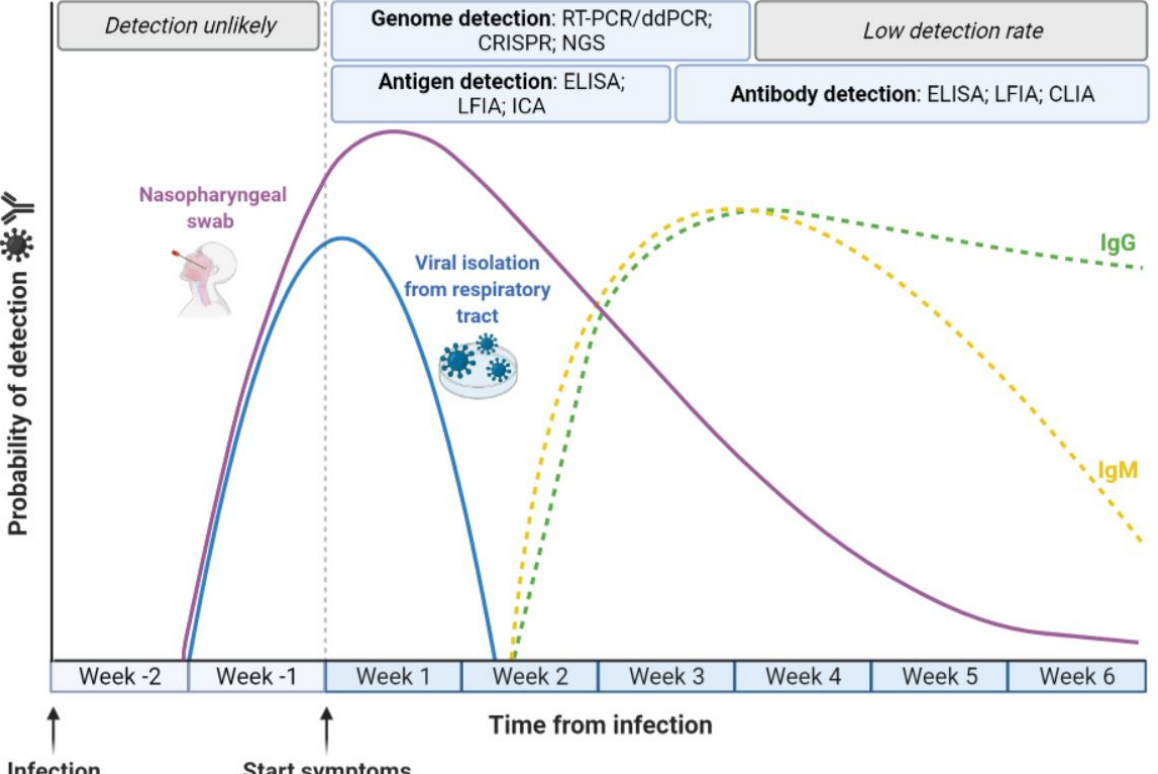
Figure 1. Progression of SARS-CoV-2 infection and in vitro diagnostics. The detection of active SARS-CoV-2 infection is performed using molecular diagnostics, i.e., real-time reverse transcription-polymerase chain reaction (RT-PCR), droplet-digital PCR (ddPCR), clustered regularly interspaced short palindromic repeats (CRISPR) and next-generation sequencing (NGS), in order to detect the viral RNA during the first weeks after the emergence of symptoms. In this period, it is also possible to detect the presence of SARS-CoV-2 components using antigen-based immunoassays, i.e., the enzyme-linked immunosorbent assay (ELISA), lateral flow immunoassay (LFIA) and immunochromatographic assay (ICA). Detection of SARS-CoV-2 antibodies (IgG and IgM) occurs through antibody-based immunoassays, i.e., ELISA, LFIA and chemiluminescence immunoassay (CLIA), from the third week after symptoms.